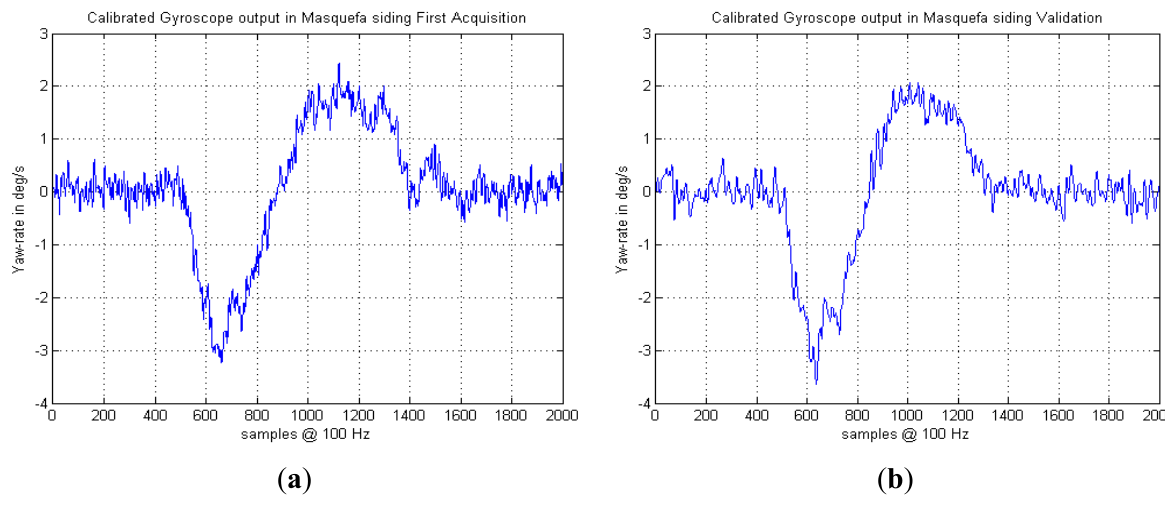
Figure 3. Yaw rates of a turnout in the Masquefa station measured in two experimental campaigns with different hardware and software. ( a ) December 2007. ( b ) December 2011. Small differences are due to gyroscope noise and slightly different train velocities and decelerations during the